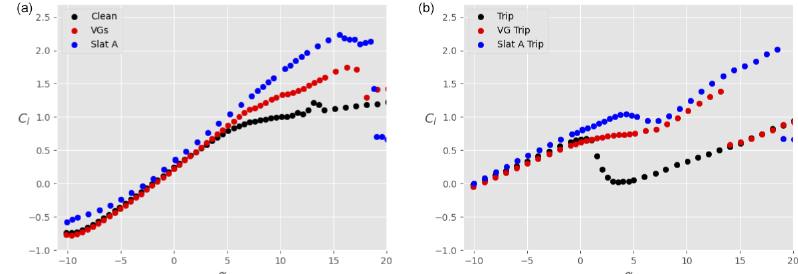
Figure 17. Lift coefficient C l as a function of the angle of attack α for the main airfoil at Re = 1 . 5 × 10 6 , without VGs and without slat (black), with VGs only (red), and with slat only in configuration A (blue). (a) Clean airfoil; (b) tripped airfoil.